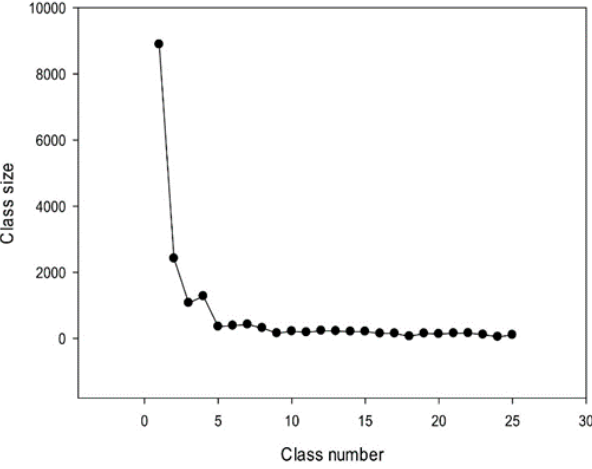
Figure 8. Sizes of 25 classes of promoter sequences identified in the A. thaliana genome.